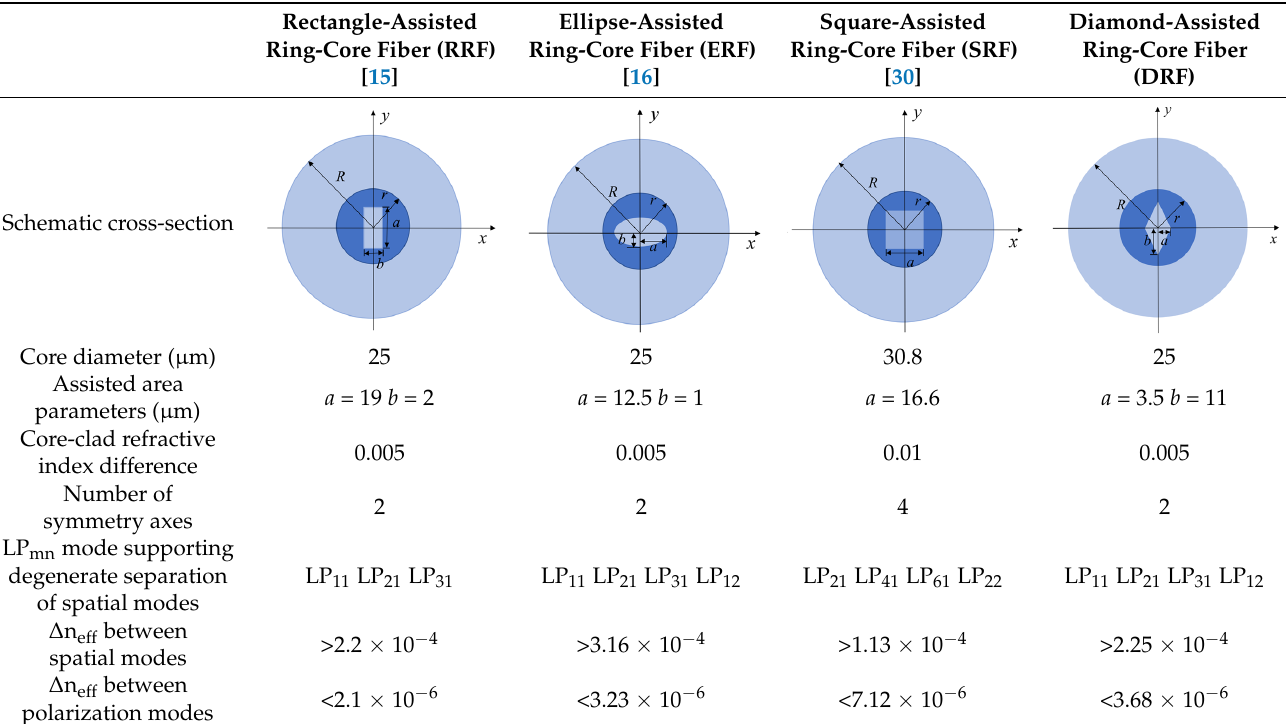
Table 2. Performance comparison of four center-assisted ring-core fibers.